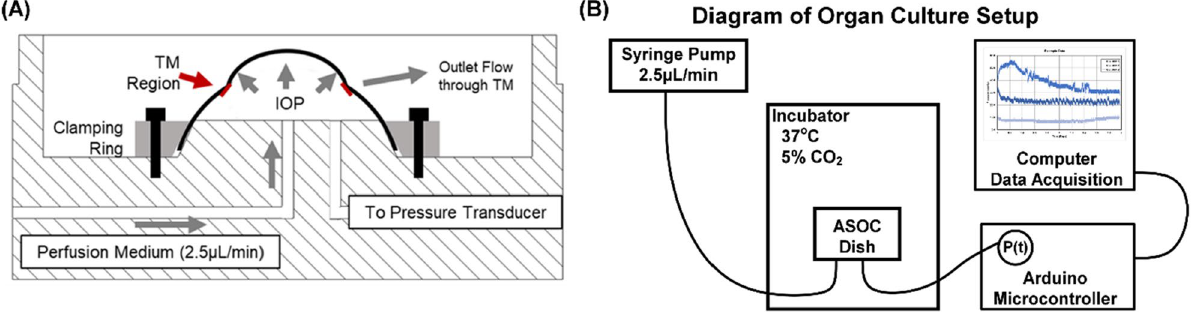
Figure 1. Overview of anterior segment organ culture setup. ( A ) Diagram of ASOC dish and clamping ring. ( B ) Diagram of the organ culture setup. Syringe pump delivers organ culture media at physiological flow rates to the ASOC setup that is kept in an incubator at 37 °C, 5% CO 2 . Additional fluidic line attached to pressure transducer records data with a microcontroller and computer in real-time. Figure 1A is reproduced from Snider et al., 2019.